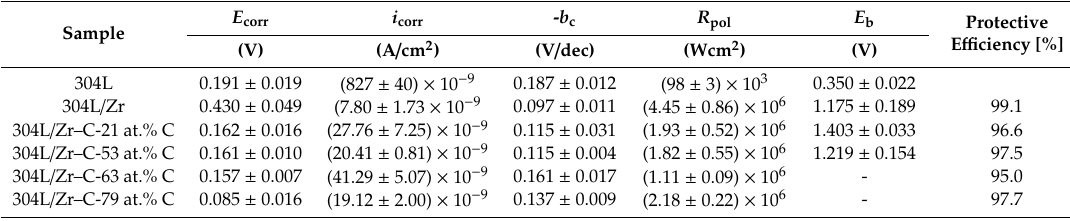
Figure 13. Polarization curves obtained for 304L steel substrate and substrate-coating systems in Fusayama-Meyer’s artificial saliva. Table 6. Electrochemical parameters characterizing corrosion processes of 304L steel substrate, bare and coated, in Fusayama-Meyer’s artificial